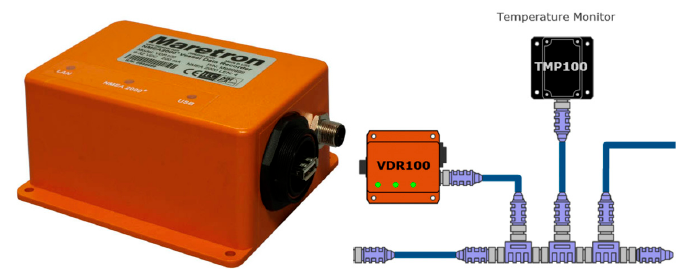
Figure 8. VDR100 Vessel Data Recorder [71].